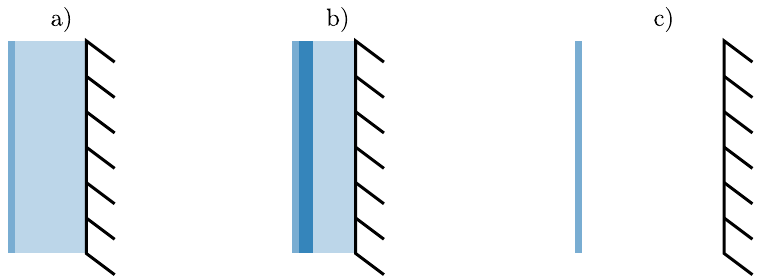
Figure 3. Test systems considered. (a) The fi lm is placed on a single layer backing. Two con fi gurations are tested: foam backing ( L = 50 mm). (b) The fi lm is set on a two-layers backing (thickness of the backing layers is respectively 10 mm and 30 mm). (c) An air plenum ( L = 200 mm) if formed behind the fi lm. The properties of the media used for these tests are reported in Table 1.